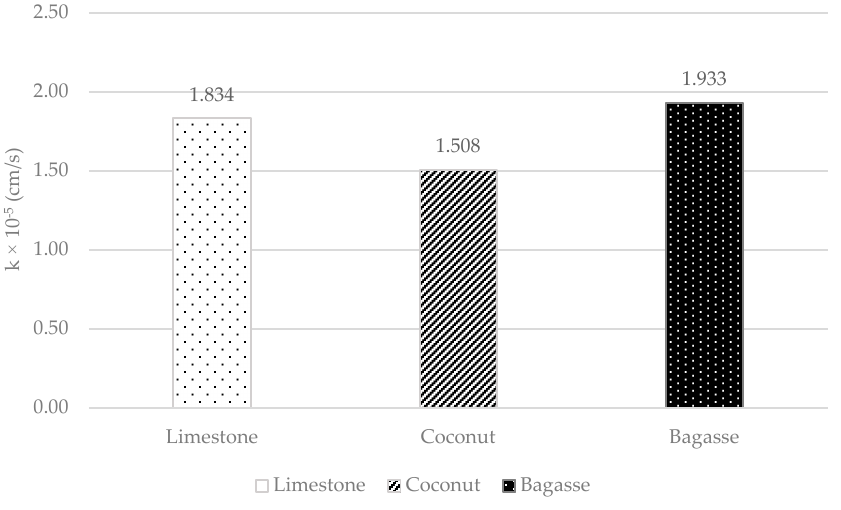
Figure 6. The coefficient of water permeability in porous asphalt mixtures.